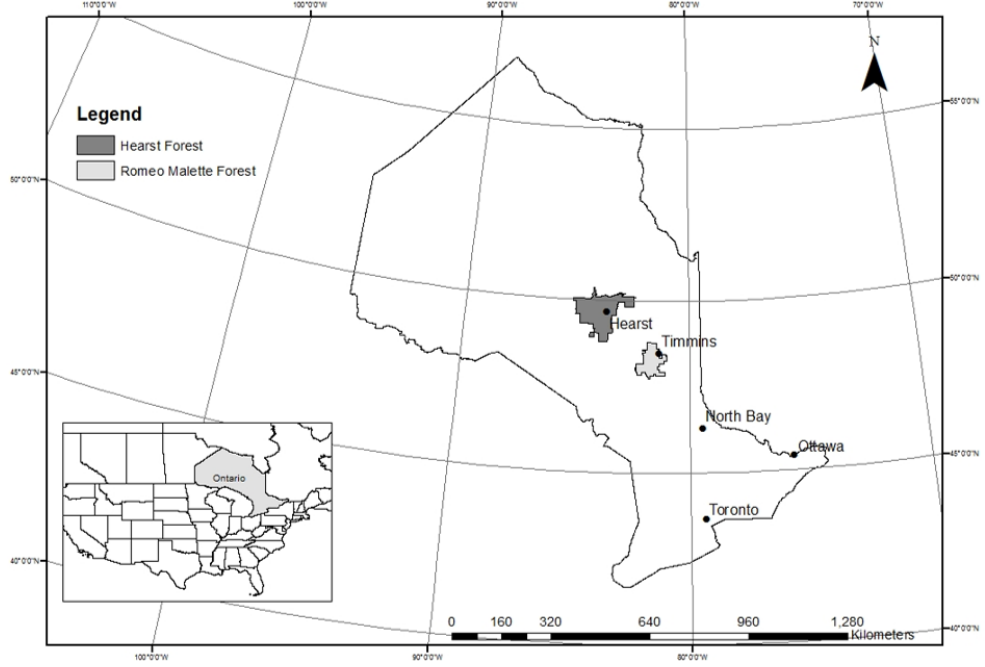
Figure 1. The location of the Hearst and Romeo Malette Forests in Ontario,